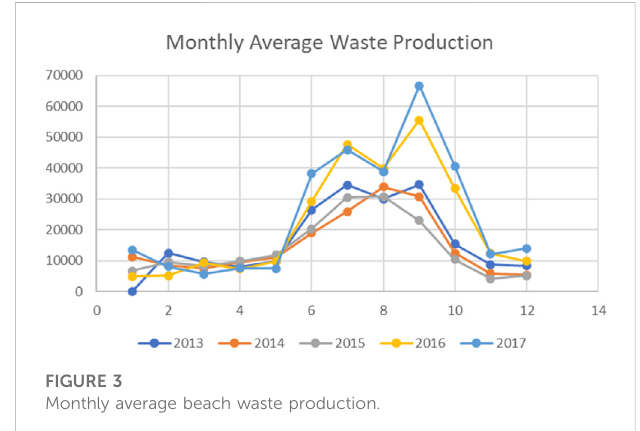
FIGURE 3 Monthly average beach waste production.